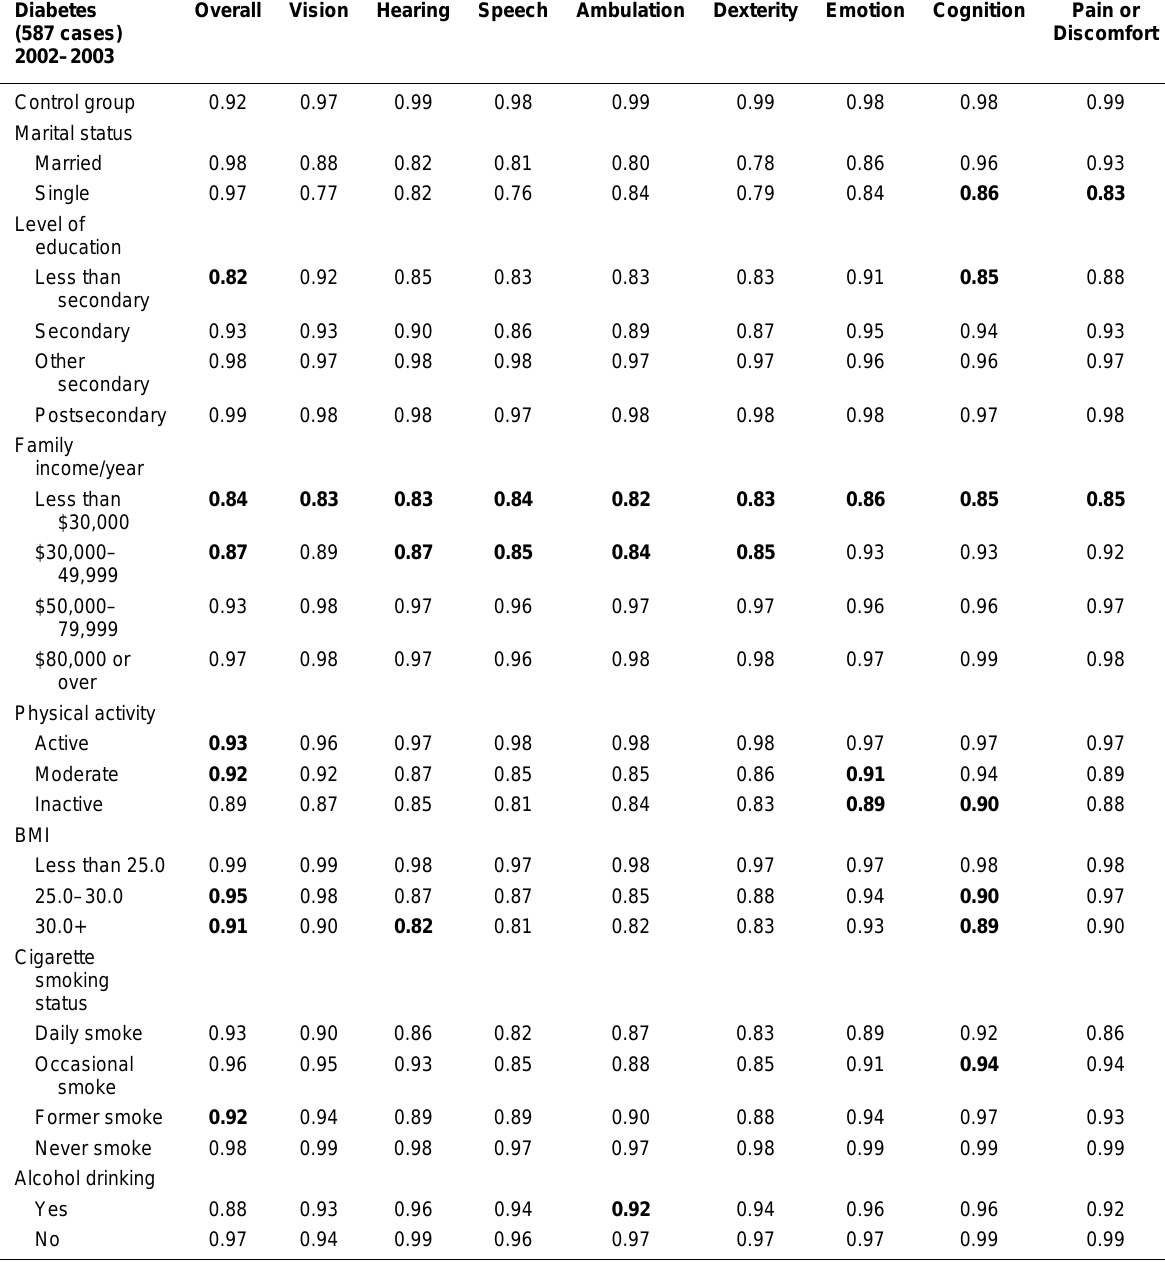
Adjusted Mean of Overall HUI3 and Single-Attribute Scores Related to Diabetes, NPHS Longitudinal Data, from 1994–2003